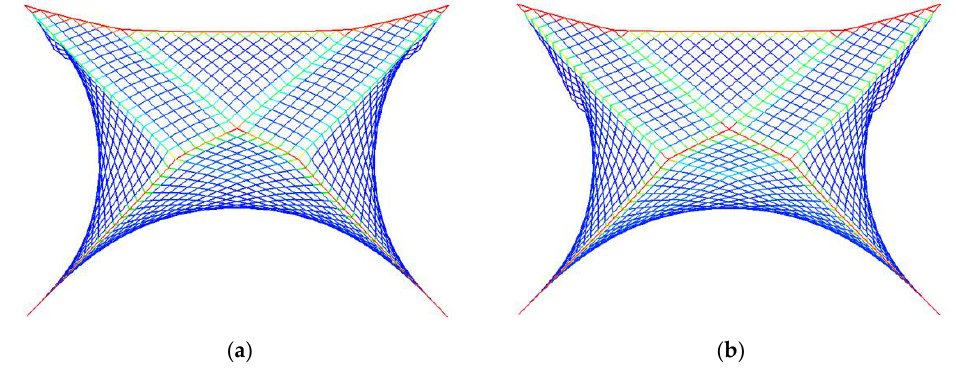
Figure 5. Deformation and tension distribution of trash-blocking net in current: ( a ) high water level; and ( b ) low water level.